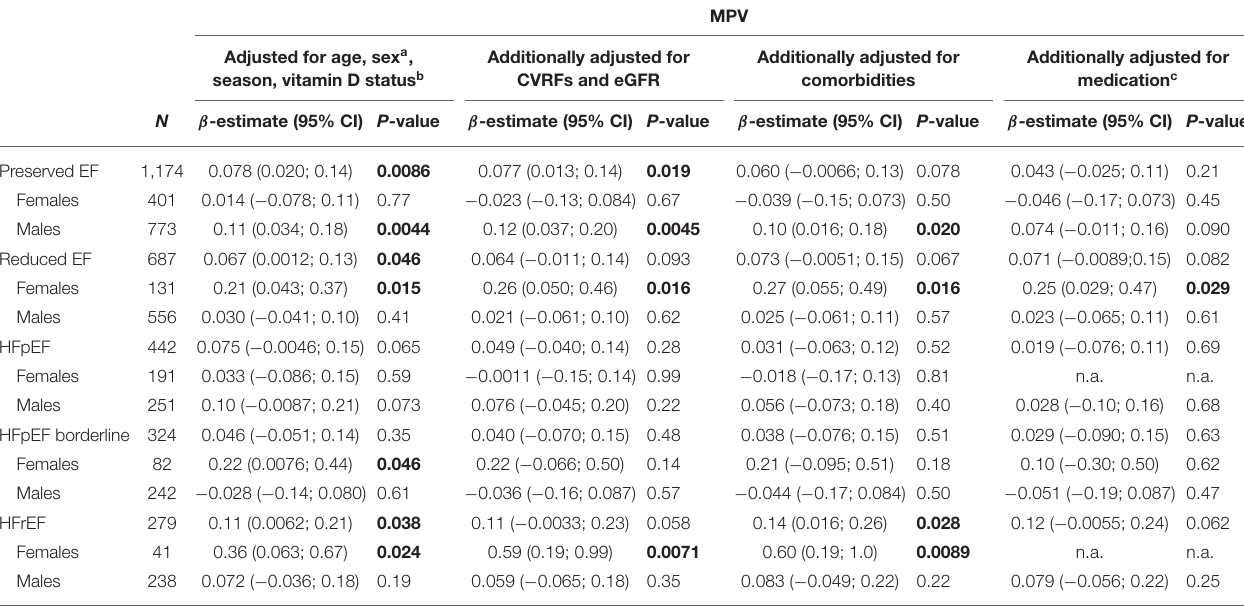
TABLE 2 | Relation between MPV and PTH according to cardiac function in a sex-specific